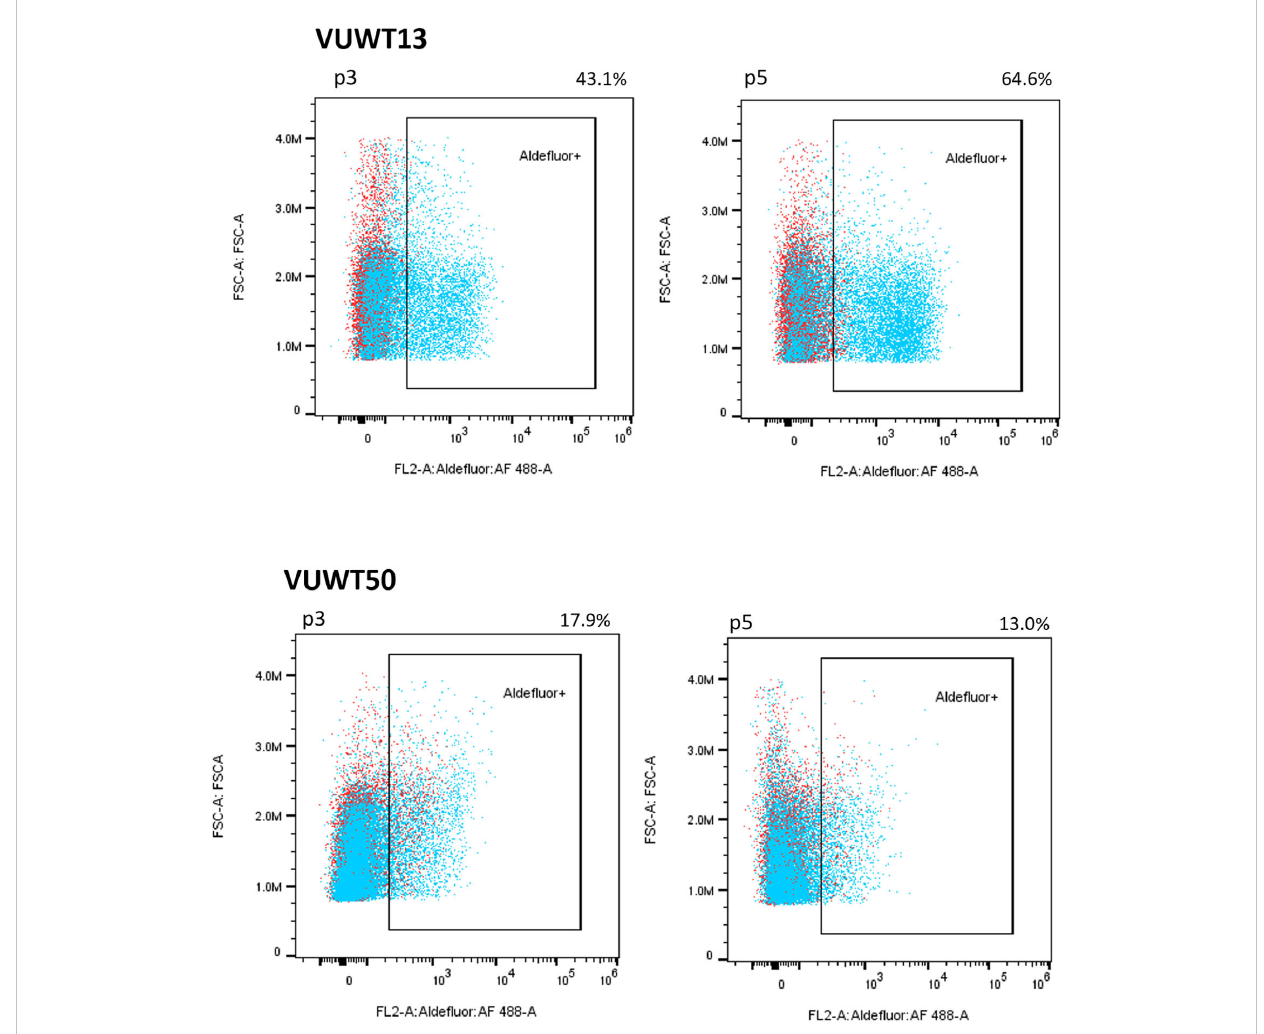
FIGURE 4 VUWT13 and VUWT50 cultures contain signi fi cant stable populations of ALDH1+ cells as determined by an Alde fl uor fl ow cytometric